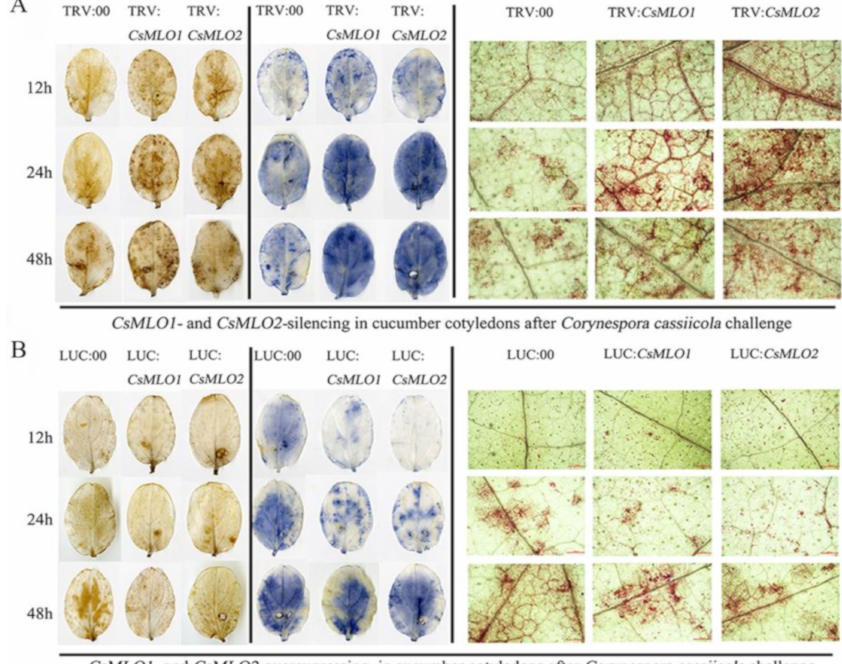
Figure 7. Vital staining of di ff erent times were surveyed in transgenic cucumber cotyledons after treatment with C. cassiicola . ( A ) The accumulation of H 2 O 2 and O 2 · − using the 3,3 (cid:48) -diaminobenzidine (DAB) and nitrotetrazolium (NBT) staining methods showed dye accumulation after treatment with C. cassiicola in silencing plants. Cell wall reinforcement showed dye accumulation after treatment with C. cassiicola by lignin staining. ( B ) The accumulation of H 2 O 2 and O 2 · − using the DAB and NBT